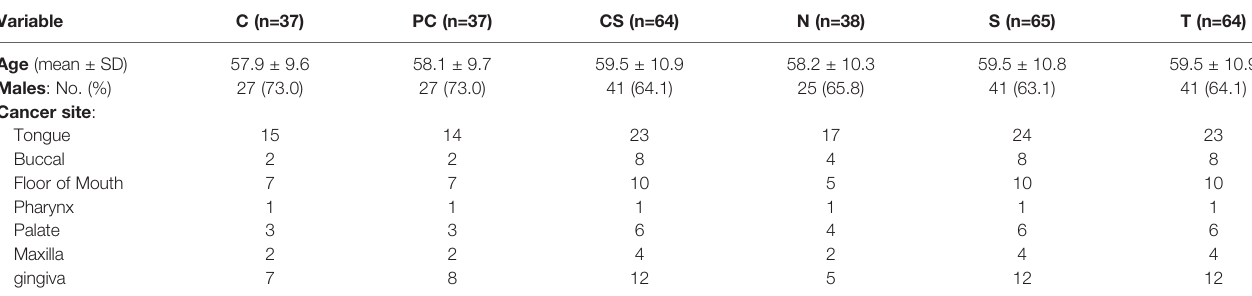
TABLE 1 | Clinicopathological characteristics of the patients.